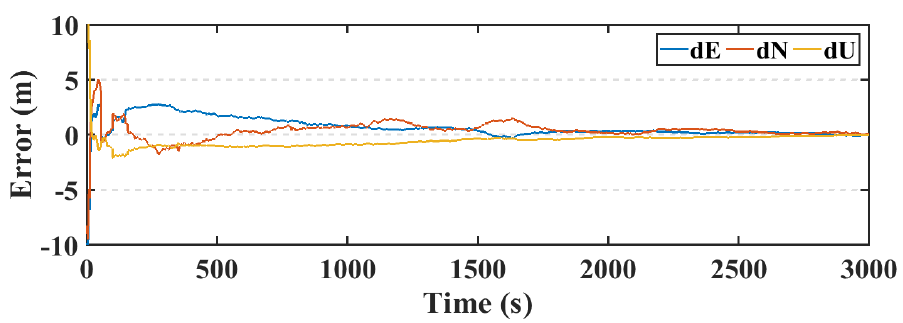
Figure 21. Position errors for the RT-PPP solution (kinematic/first dataset).